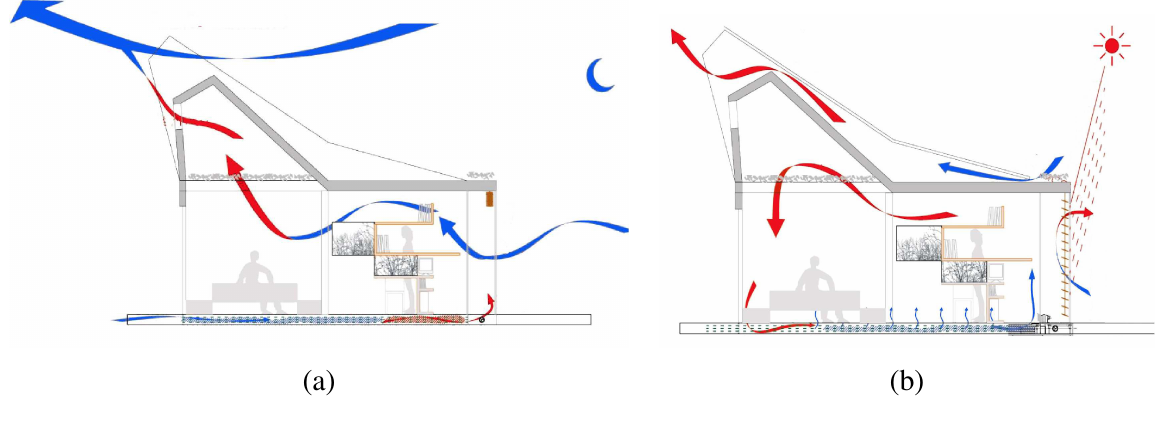
Figure 3. Temperature control in a summer (a) night and (b)